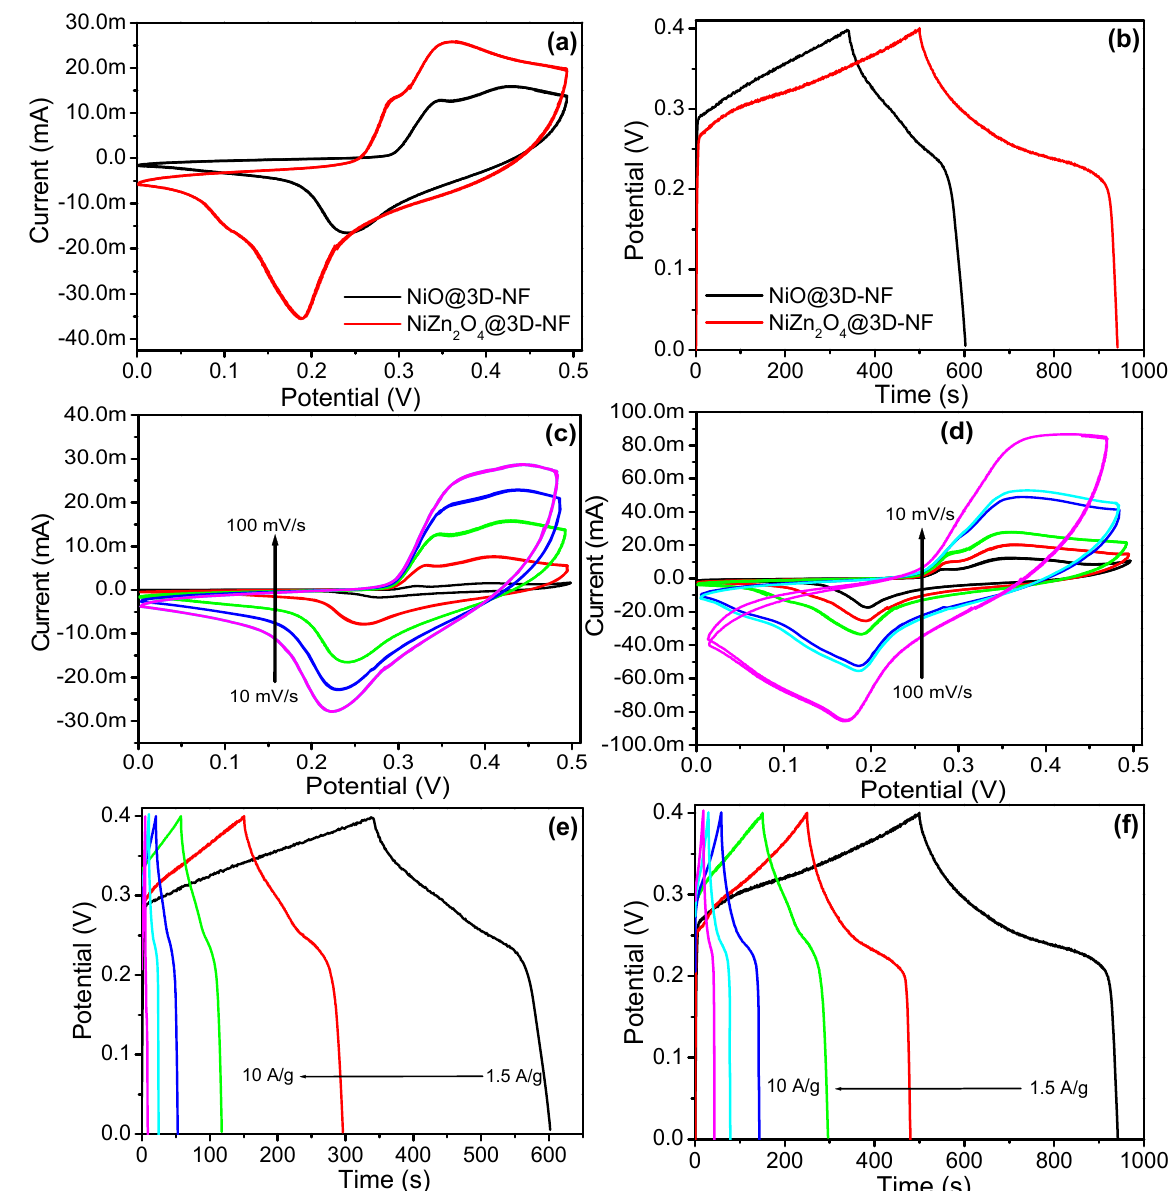
Figure 4. ( a ) Comparative CV of NiO@3D-NF and NiZn 2 O 4 @3D-NF; ( b ) comparative GCD graph of NiO@3D-NF and NiZn 2 O 4 @3D-NF; ( c ) CV of NiO@3D-NF at different scan rates; ( d ) CV of NiZn 2 O 4 @3D-NF at different scan rates; ( e ) GCD graph of NiO@3D-NF at different current densities; and ( f ) GCD graph of NiZn 2 O 4 @3D-NF at different current densities.